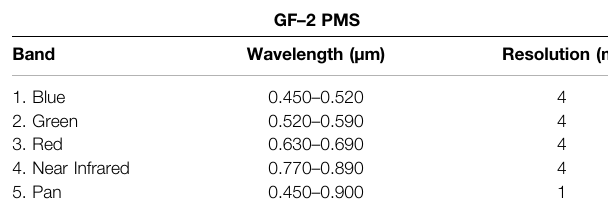
TABLE 1 | Spectral bands of GaoFen-2 (GF-2) Panchromatic/Multi- Spectral